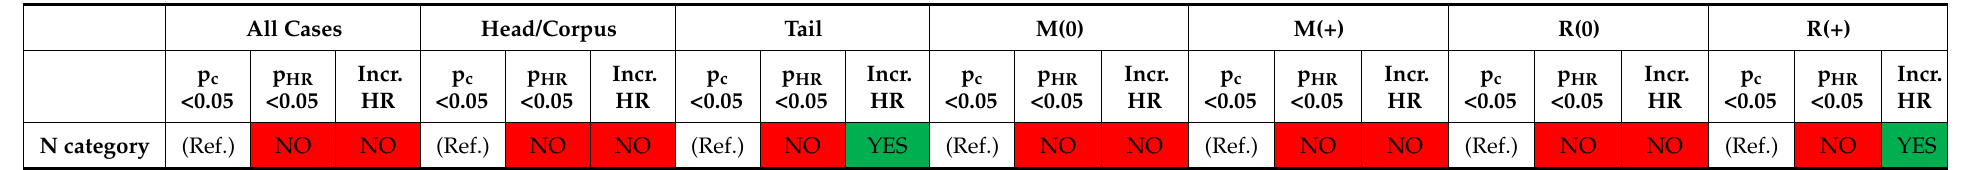
Table 5. Presentation of N category and its statistical significance (YES/NO) with regard to Cox regression (p HR ) and ascending values of Hazard Ratios parallel to the assorted risk groups (Incr. HR) for various patient subgroups. Classifications that satisfy all investigated parameters are marked